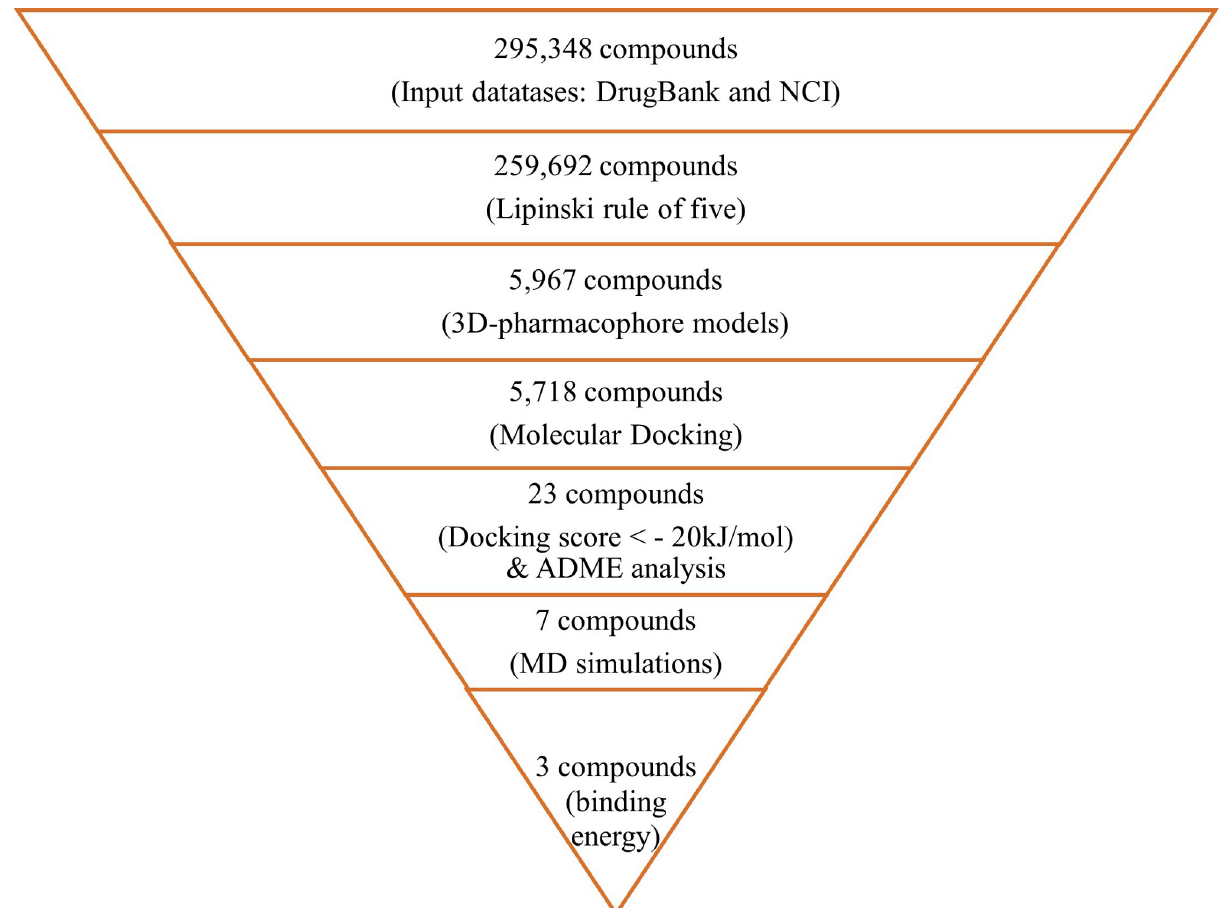
The free energy of IL-8 binding was primarily contributed from the E the free binding energy of this compound was higher than the two remaining complexes. Gen- erally, the binding free energies values were clearly low, especially for DB14770. One explana- tion might be the contribution of the electrostatic energy, which is highly influenced by the dielectric constant ( ε ). The dielectric constant’s value depends on the binding site’s character- istics between the protein and each ligand. It has been suggested that ε should be varied with